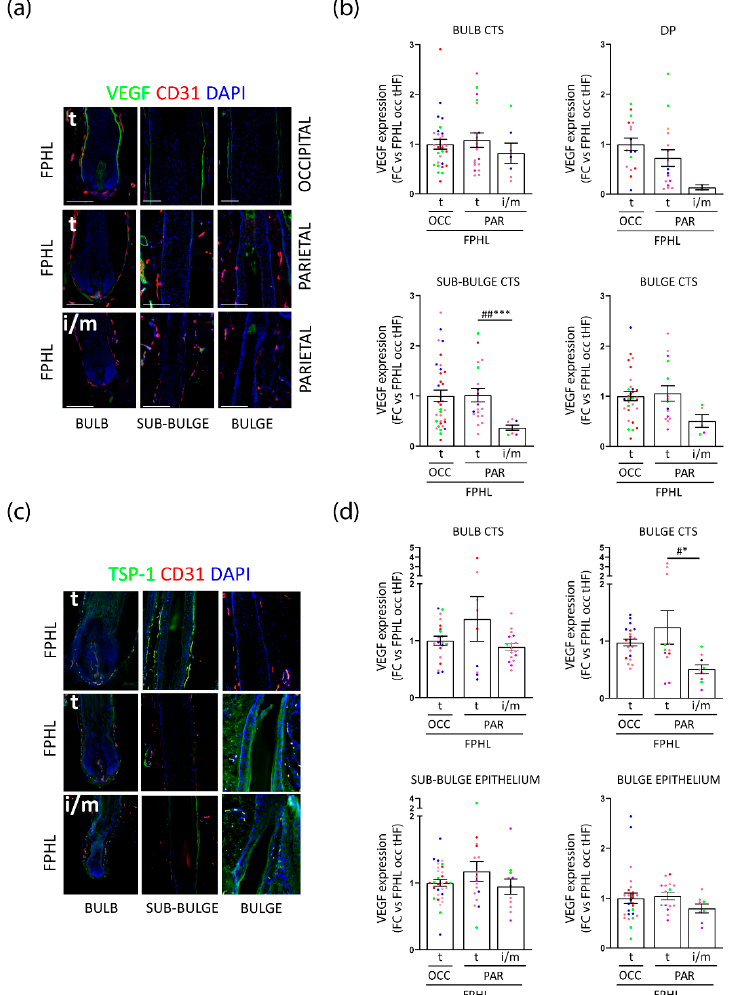
Figure 4. Intermediate parietal HFs display lower VEGF and TSP-1 expression. ( a ) Representative images of in situ Vascular Endothelial Growth Factor(VEGF)/Cluster of Differentiation 31 (CD31) (double immunofluorescence staining of the bulb, sub-bulge, and bulge areas of a terminal (t) hair follicle from FPHL occipital scalp skin and of a terminal, and an intermediate/miniaturized (i/m) hair follicle from FPHL parietal scalp skin. ( b ) VEGF protein expression levels were measured by quantitative (immuno-)histomorphometry in the connective tissue sheath (CTS) of hair follicle bulb, sub-bulge, and bulge regions, and in the dermal papilla (DP) of intermediate/miniaturized (i/m) and/or terminal (t) hair follicles from n = 4–5 FPHL donors (1: red, 2: green, 3: blue, 4: purple, 5: pink). Mean ± SEM from 2–34 hair follicles/group. GraphPad 9.0. Kruskal–Wallis with Dunn’s multiple comparison ## p < 0.01; Multiple Unpaired t -test or Mann Whitney test (Original FDR method -Benjamini and Hochberg − 5%FDR correction), *** p < 0.001. ( c ) Representative images of in situ TSP-1/CD31 double immunofluorescence staining of bulb, sub-bulge, and bulge areas of a terminal hair follicle from FPHL occipital scalp skin and of a terminal, and an intermediate/miniaturized hair follicle from FPHL parietal scalp skin. ( d ) TSP-1 protein expression was measured by quantitative (immuno-)histomorphometry in the connective tissue sheath (CTS) of hair follicle bulb, and bulge and in the hair follicle epithelium at the sub-bulge and bulge level of intermediate/miniaturized (i/m) and/or terminal (t) hair follicles from n = 4–5 FPHL donors (1: red, 2: green, 3: blue, 4: purple, 5: pink). Mean ± SEM from 8–27 hair follicles/group. GraphPad 9.0. (CTS) Ordinary one-way Anova with Tukey’s multiple comparison test # p < 0.05; Multiple Unpaired t -test (Original FDR method -Benjamini and Hochberg − 5%FDR correction), * p < 0.05; (epithelium) Kruskal-Wallis with Dunn’s multiple comparison, not significant (n.s.); multiple Mann Whitney test (Original FDR method -Benjamini and Hochberg − 5%FDR correction),